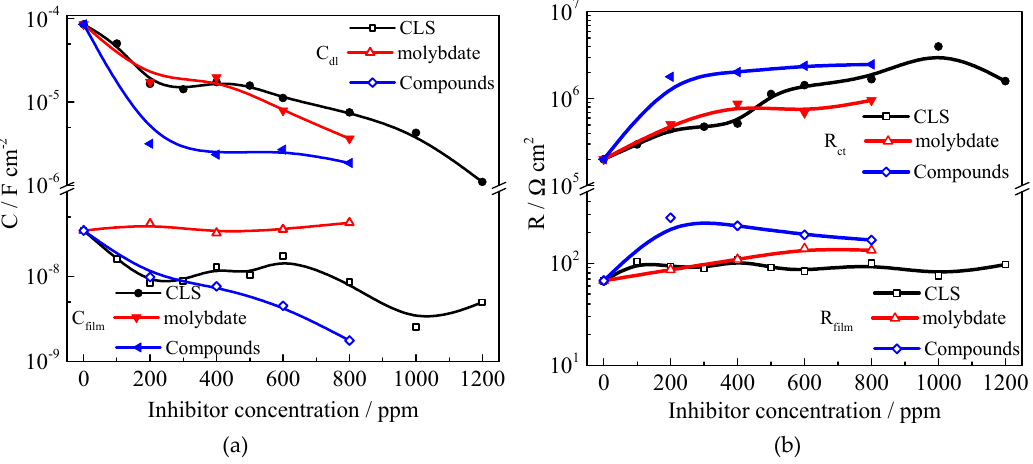
Figure 6. Electrochemical parameters of Q235 steel in carbonated SCP solution with different concentrations of inhibitor using electrochemical impedance spectroscopy (EIS) measurements, ( a ) C dl and C film ; ( b ) R ct and R film .